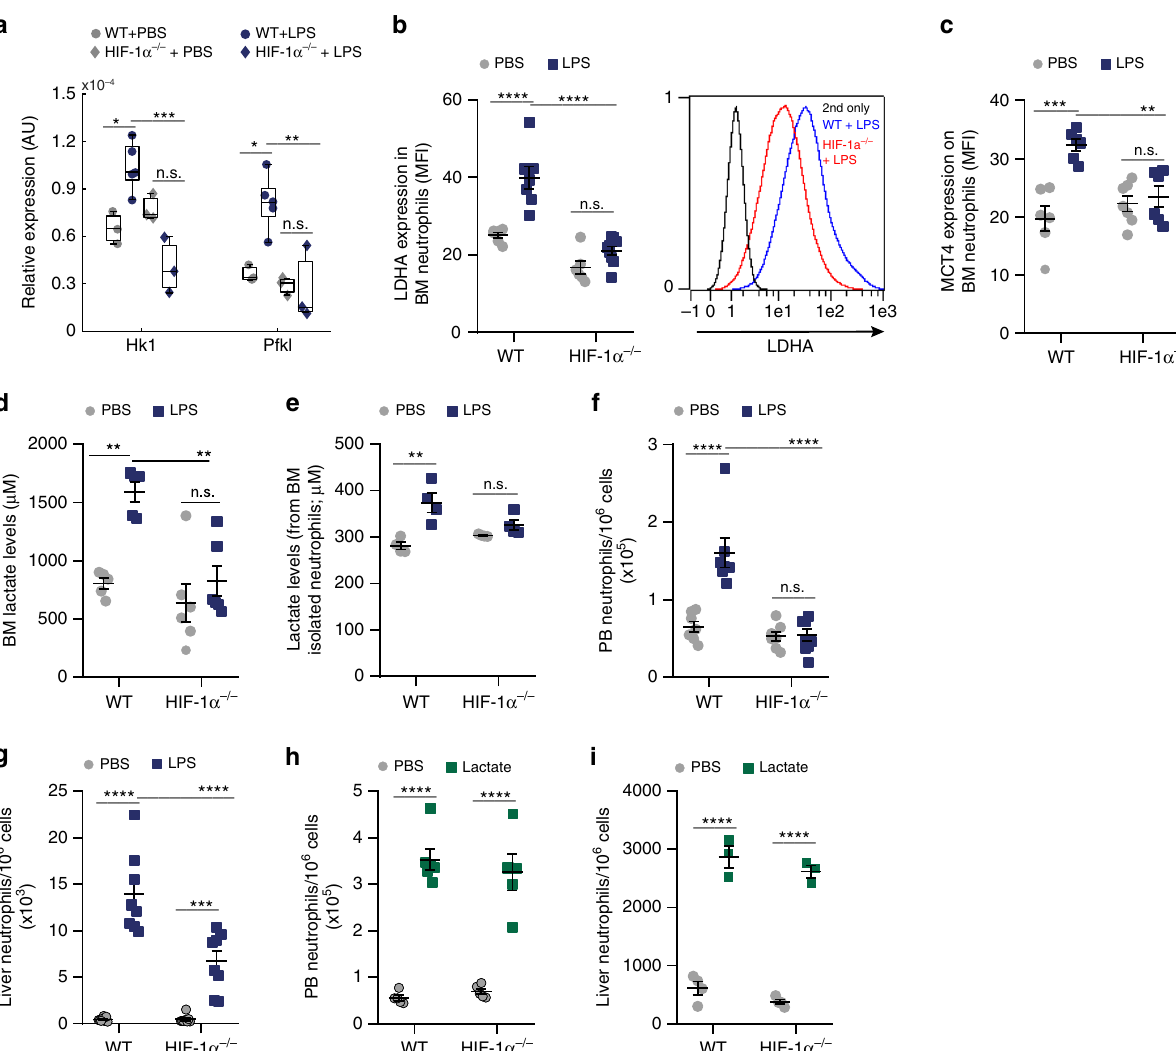
endothelial lactate/GPR81 signaling in neutrophil mobilization, we generated inducible endothelial-speci fi c GPR81 KO mice. We observed a signi fi cant lactate-induced reduction in BM neutrophil